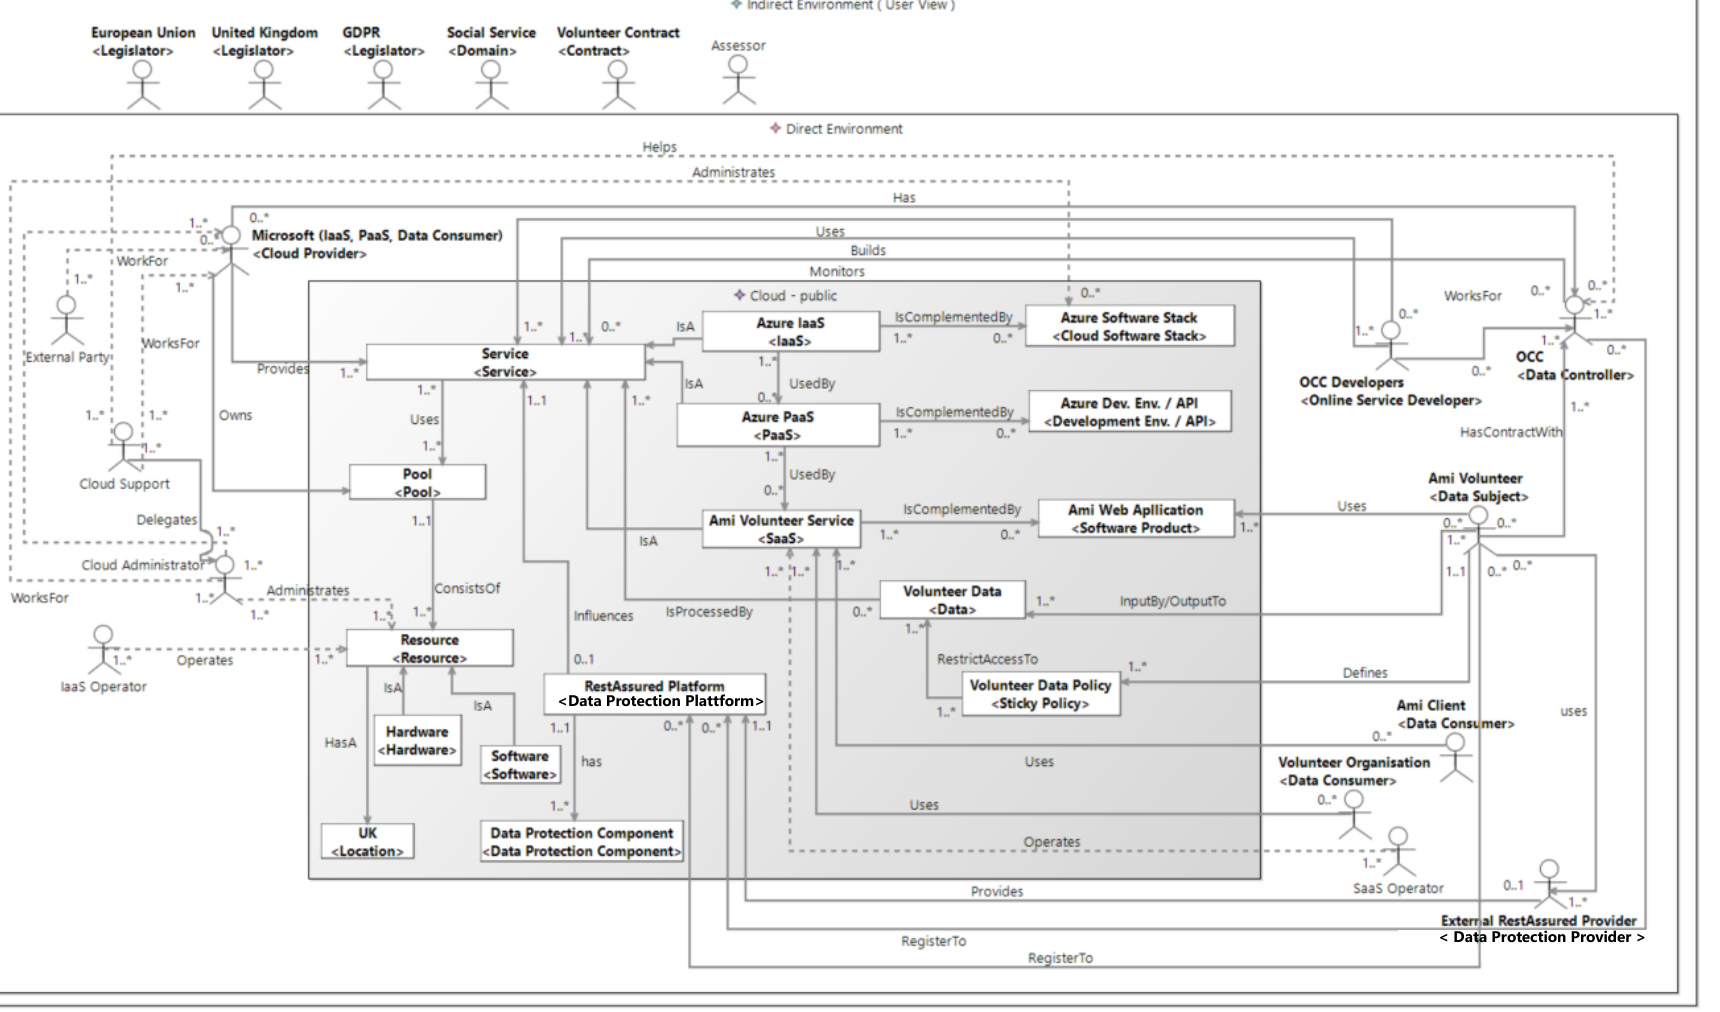
Figure 3. Instantiation of the ReAs-CSAP for the Ami volunteer service use